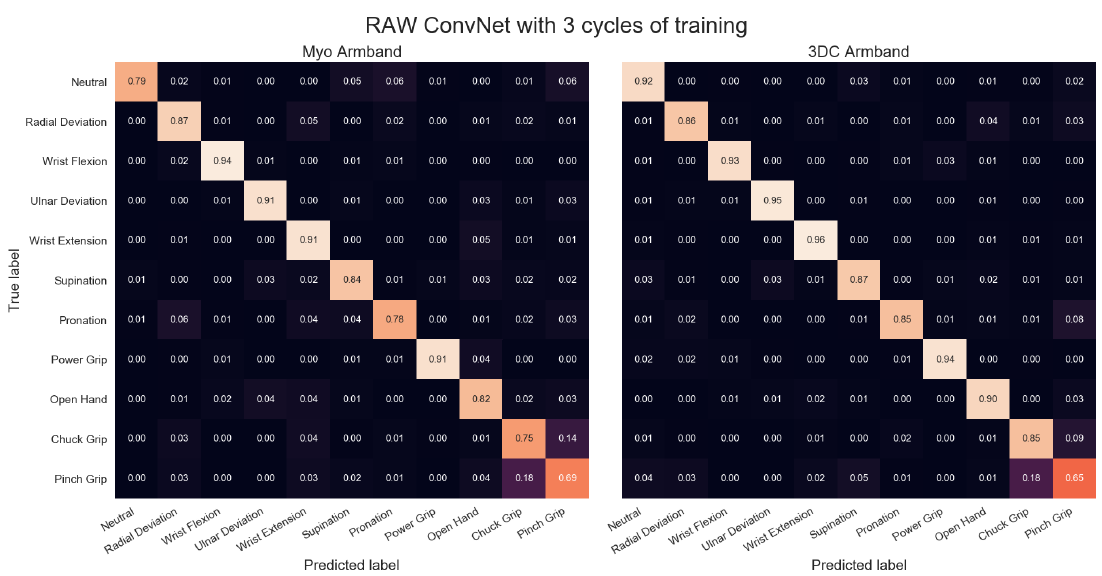
Figure A6. Confusion Matrices for the Myo and the 3DC Armband employing the Raw ConvNet for classification and three cycles of training. Lighter is